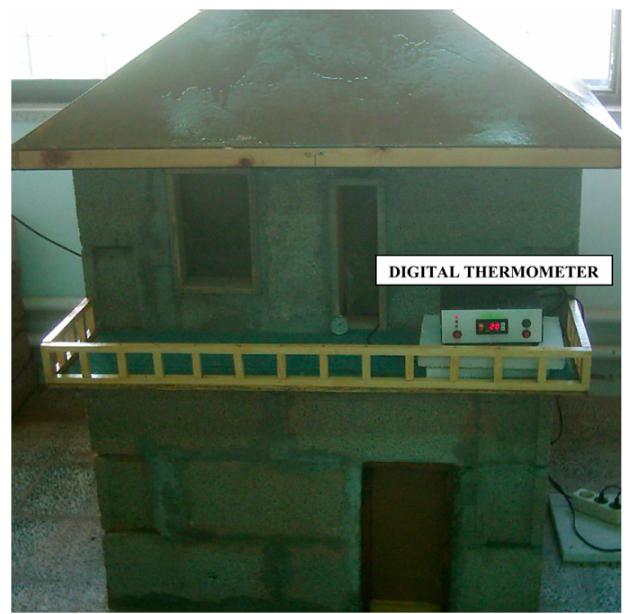
Figure 14. Model house built with fiber-reinforced mud bricks [57].